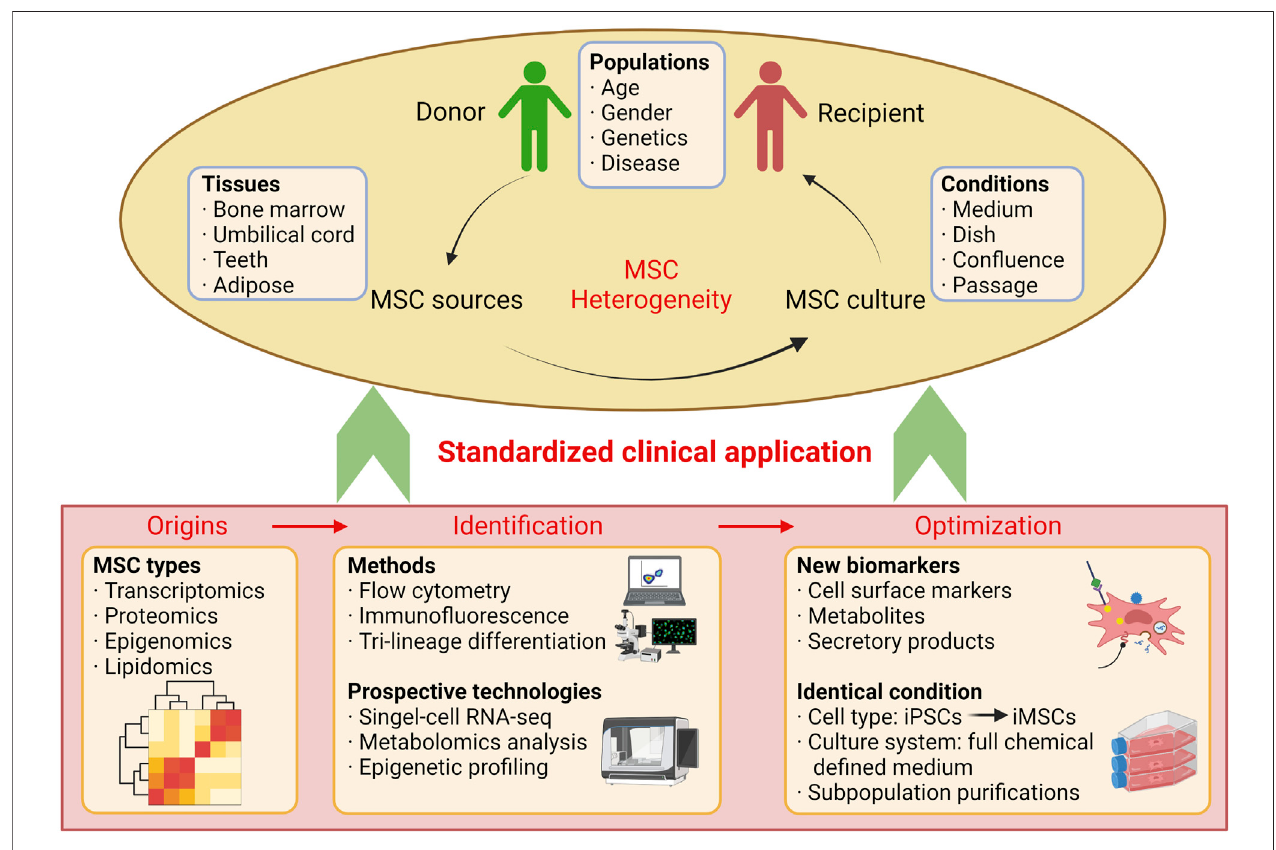
FIGURE 1 | Illustration of MSC